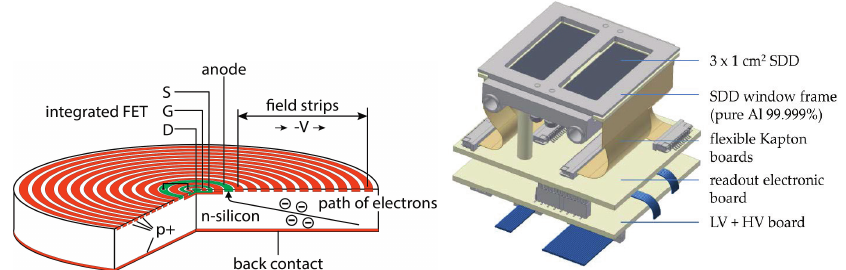
Figure 3: Scheme of SDD structure integrated with JFET (S = source, G = gate, D = drain) and reset mechanism (left). Subdetector unit, used in the SIDDHARTA experiment, including two SDD chips (each with three individual cells). Adapted from [ 1,32 ] .